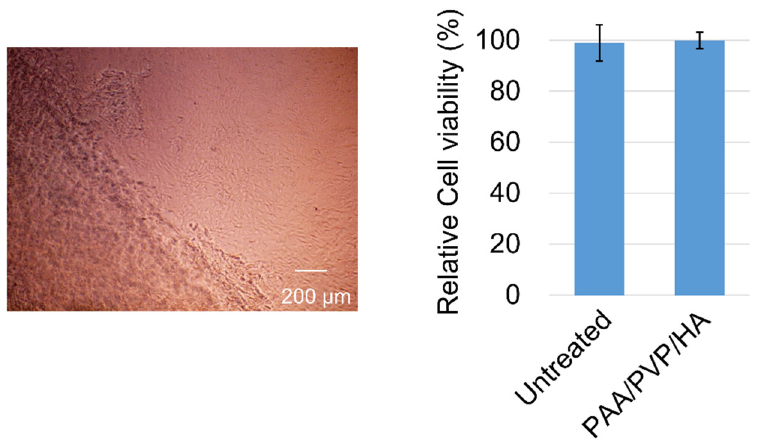
Figure 6. Viability and microscopic image of the fibroblasts cultured with a solid PAA/PVP/HA sponges. Data are presented as mean (SD).